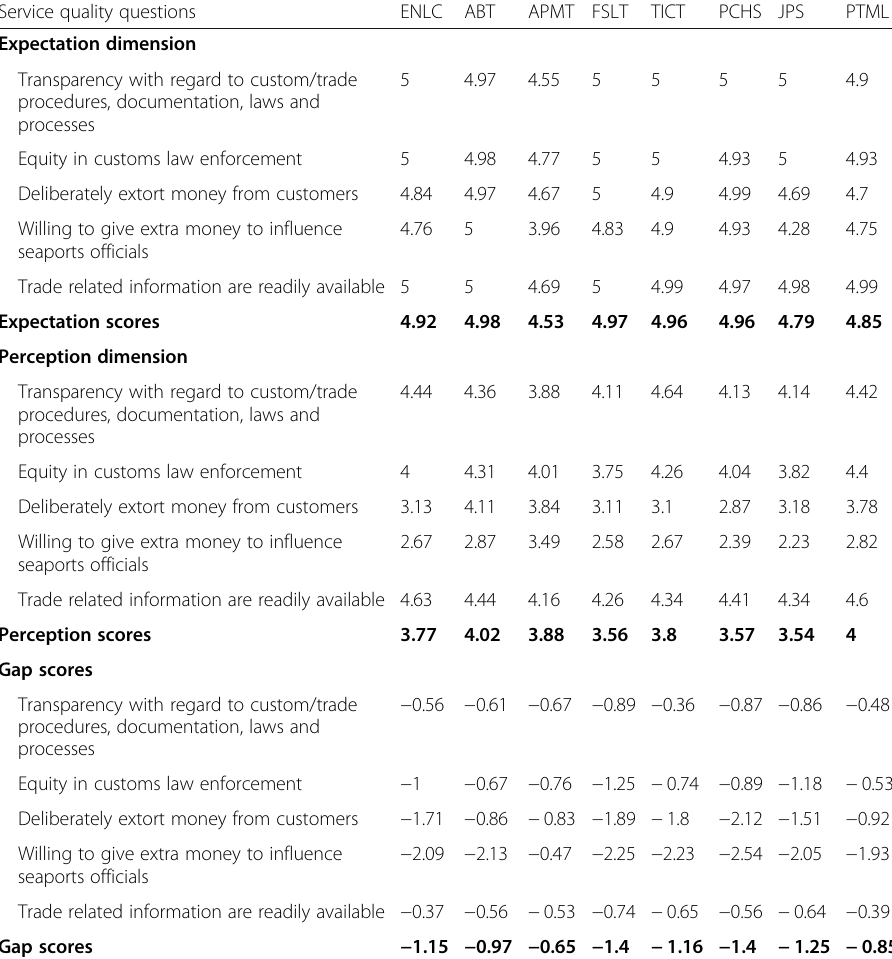
Table 9 Service quality expectation and perception average scores for transparency Service quality questions ENLC ABT APMT FSLT TICT PCHS JPS PTML Expectation dimension